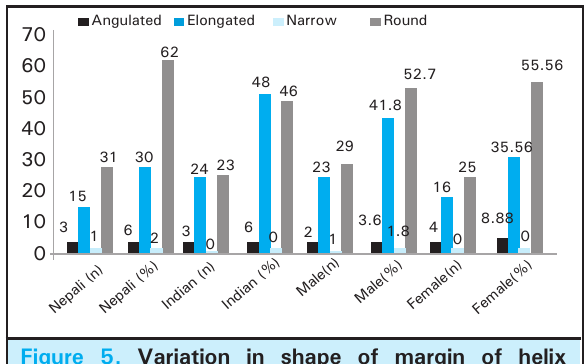
Figure 5. Variation in shape of margin of helix according to the nationality and gender